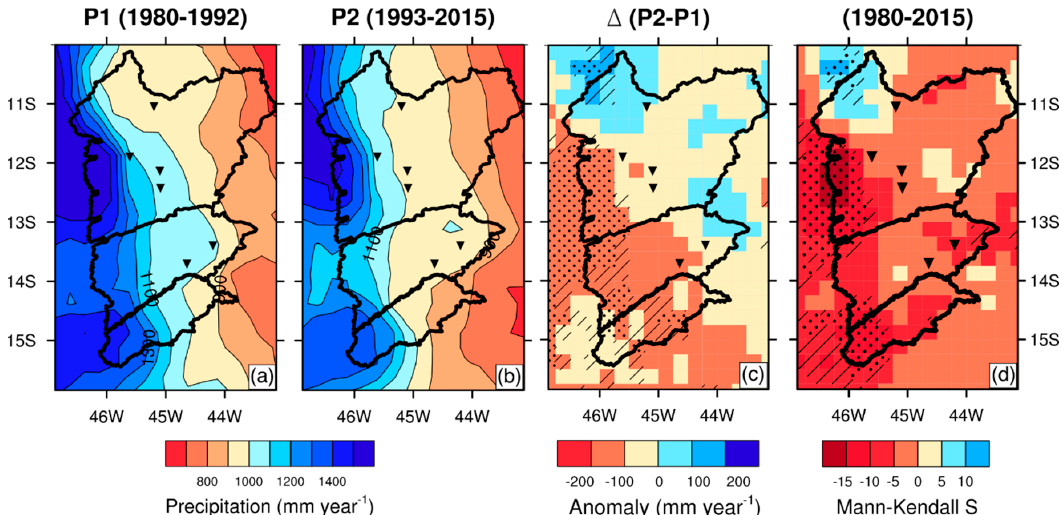
Figure 4. Average precipitation map for periods P1 ( a ), P2 ( b ) the difference between P2 and P1 ( c ), and the Mann–Kendall S statistic (negative values represent decreasing trends). The six selected river flow stations are also shown. Dotted areas represent differences significant at α = 0.05, according to Student´s t test (in c ), or according to the Mann-Kendall test (in d ), while shaded areas represent differences or trends significant at α = 0.10.